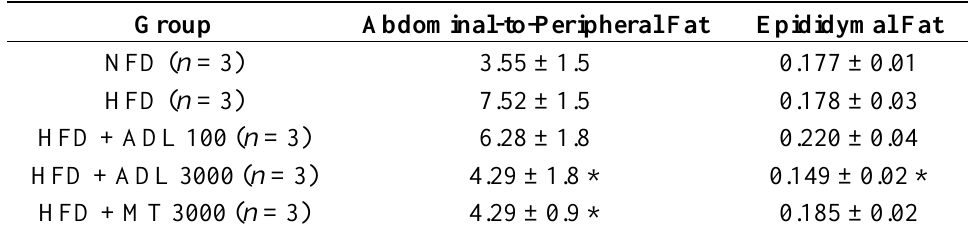
Table 3. Effects of Allomirina dichotoma larva (ADL) on relative organ